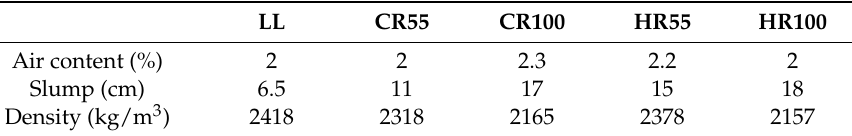
Table 4. Fresh concrete properties.